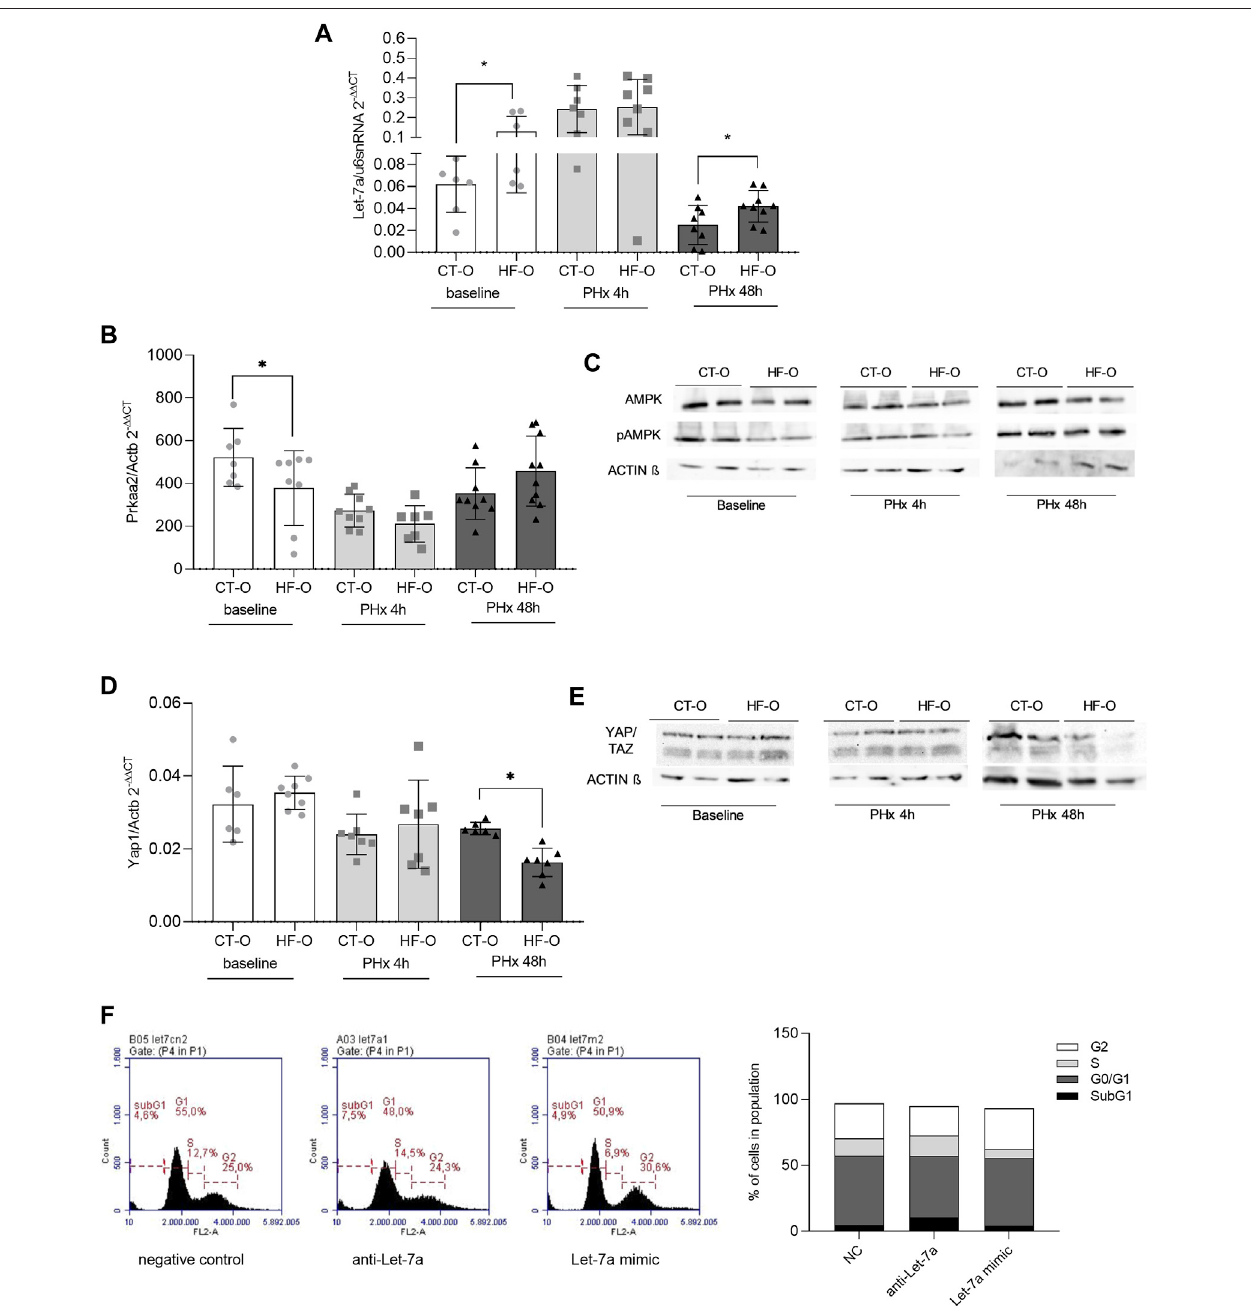
FIGURE 3 | Hepatic Let-7a pathways in the liver of the offspring of control and obese dams after partial hepatectomy. Hepatic Let-7a-5p (A) and Prkaa2 (B) gene expression(qPCR),AMPKa2andpAMPKa2immunoblotting (C) ,YAP1 (D) geneexpression(qPCR),andYAP/TAZimmunoblotting (E) fromtheoffspringofcontrol(CT- O)andobese(HF-O)dams,before(baseline)or4 h(PHx4 h)or48 h(PHx48 h)afterpartialhepatectomysurgery.Dataareplottedasindividualvalues(dotplots),means and SEM,represented byvertical bars. n= 5 – 10/group.* p ≤ 0.05 and ** p ≤ 0.005 after Student ’ s t -test (CT-OversusHF-O). Representative image and histogram of cell cycle distribution ( n = 2) by fl ow cytometry in AML12 cells transfected with negative control, anti-Let-7a, or Let-7a mimic (F) .